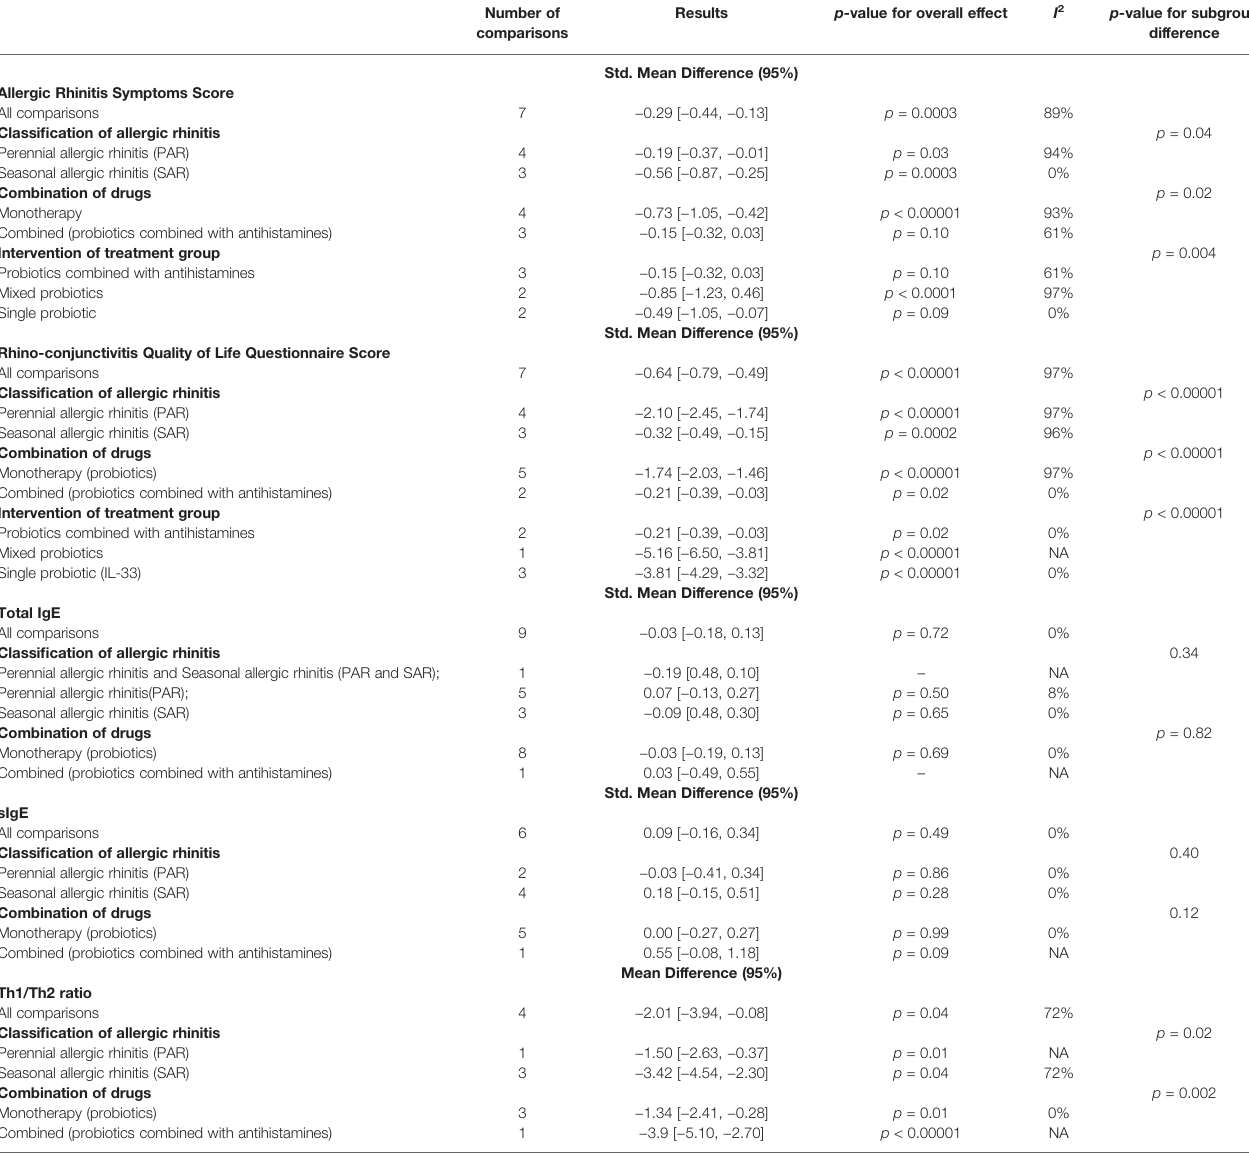
TABLE 2 | Subgroup analysis for outcomes.